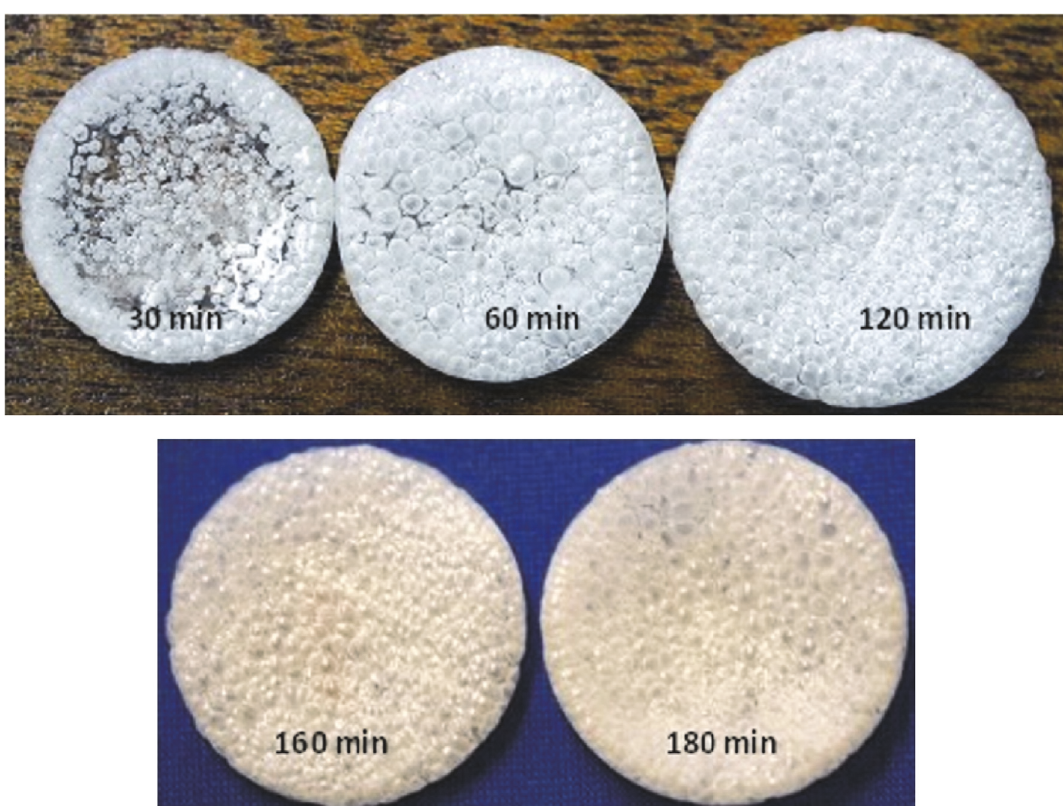
Figure 2: Photographs of samples of PS depressurized after holding for different times (30 to 180 min) at 100 ∘ C and 54 bar (1mm thickness × 20 mm diameter).